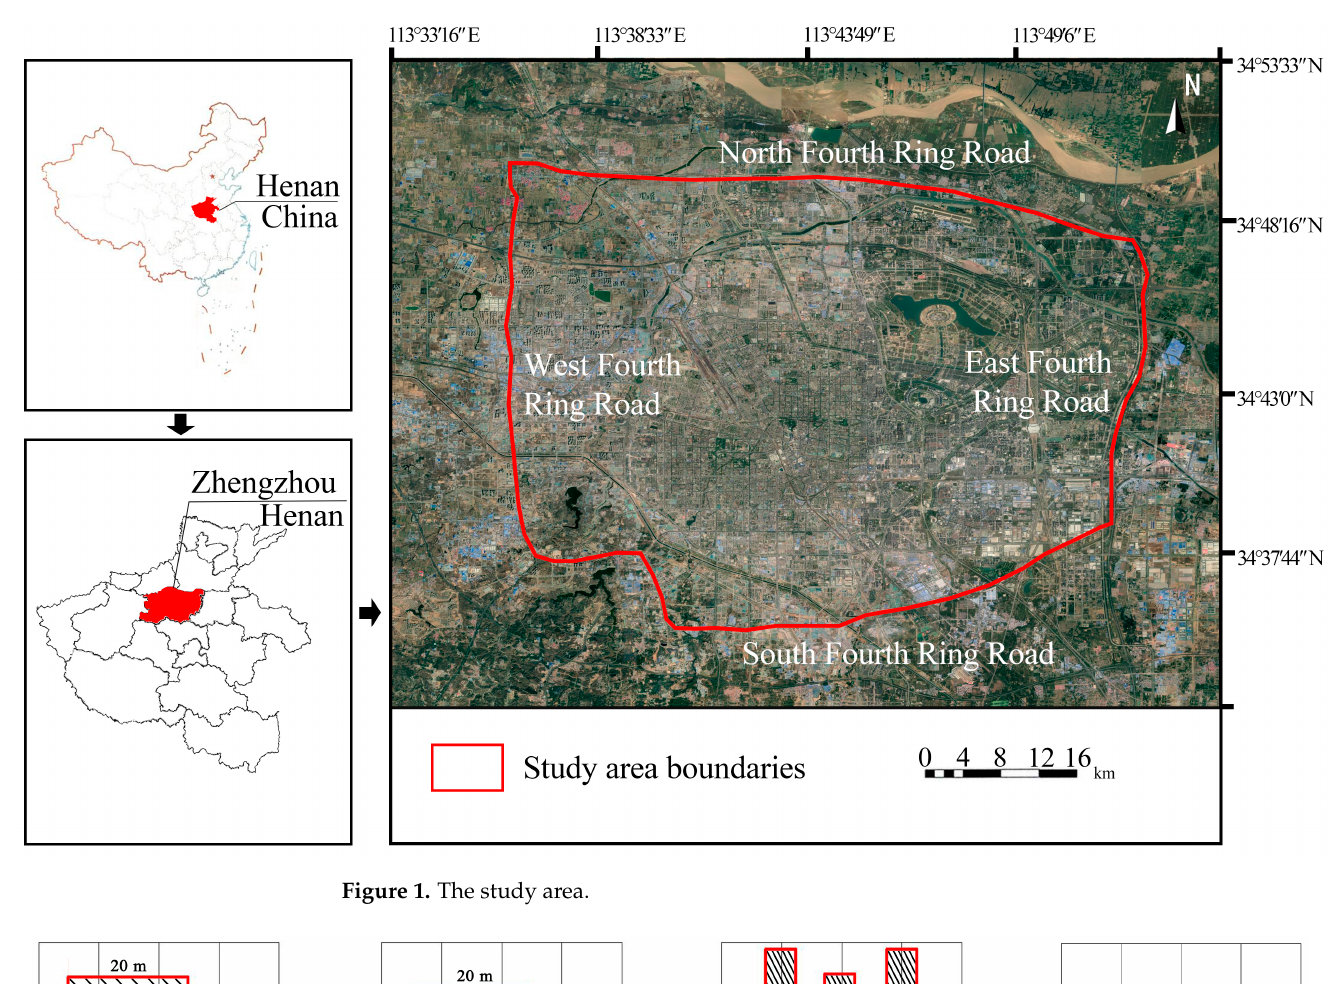
Figure 1. The study area.